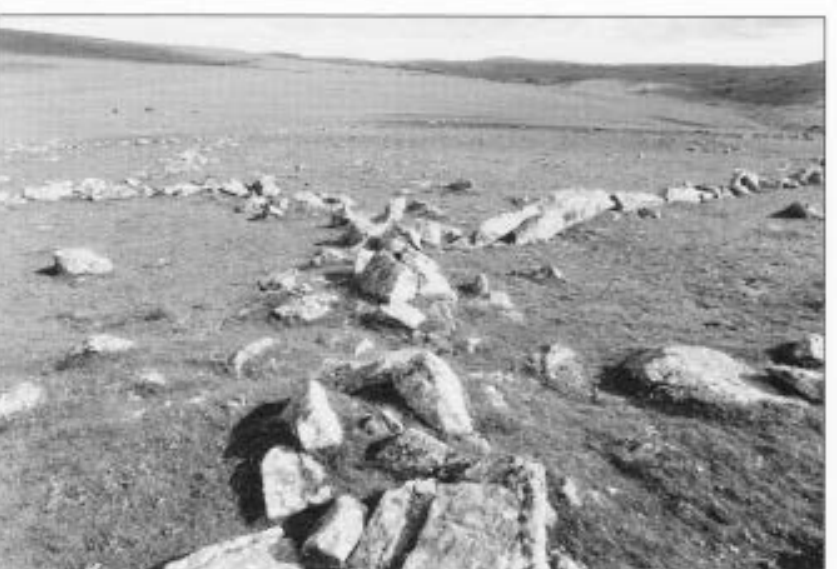
Figure 7 Wall junction in theclittersouth of house 39, southern settlement, Lesker­